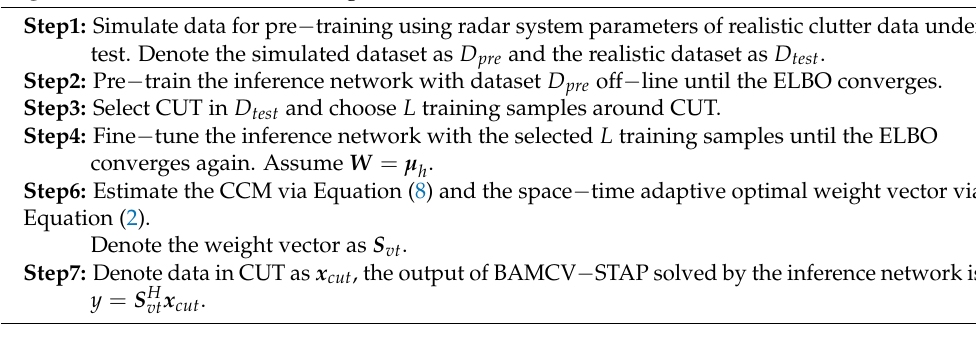
Algorithm 2 BAMCV − STAP algorithm.